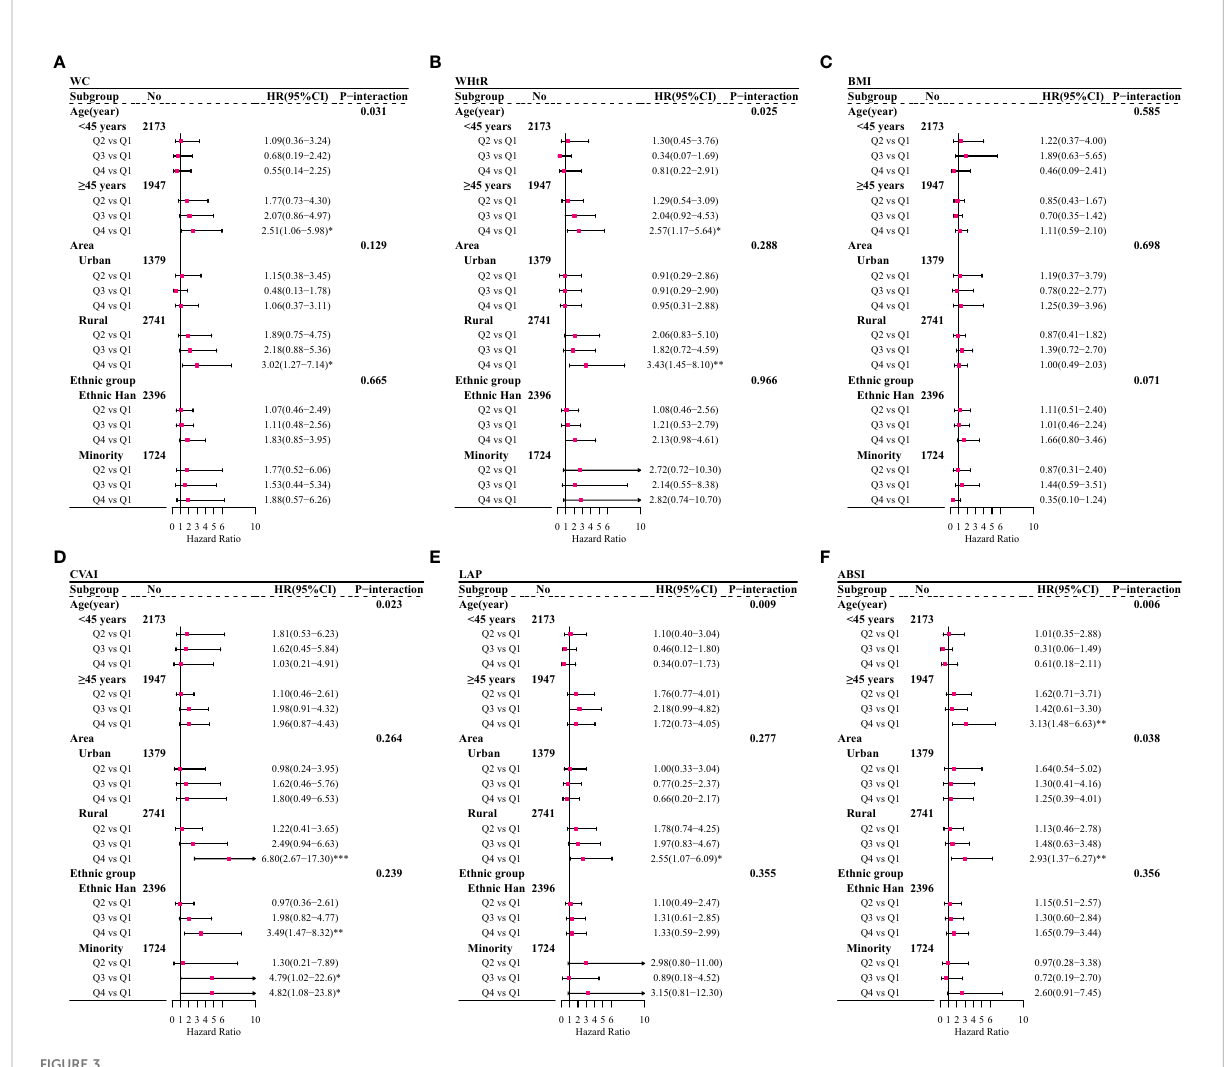
FIGURE 3 Adjusted hazard ratios (HRs) and 95% con fi dence intervals (95% CIs) for overall CVD or overall CVD associated with traditional and non- traditional anthropometric indicators among female participants after strati fi ed by age, area, and ethnic group based on adjusted Cox regression model (Model 3). (A) For waist circumference (WC); (B) for waist-to-height ratio (WHtR); (C) for body mass index (BMI); (D) for Chinese visceral adiposity index (CVAI); (E) for lipid accumulation product (LAP); (F) for body shape index (ABSI); * p < 0.05; **0.05 < p < 0.01;***0.01 < p <